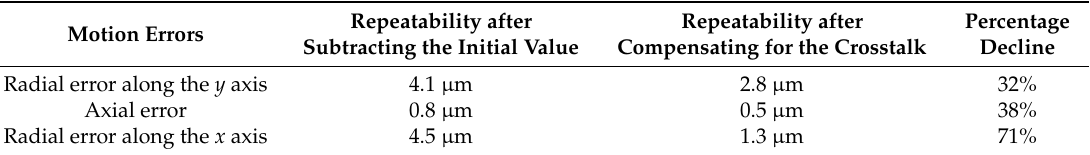
Table 3. Repeatability changes before and after crosstalk compensation.